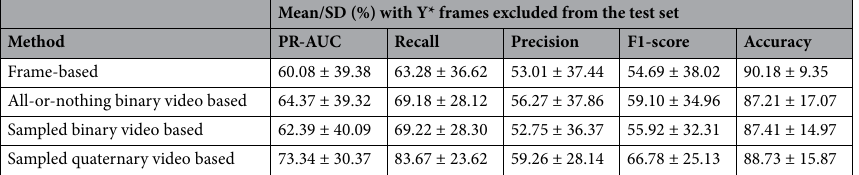
Table 5. The mean/std test-set metrics for the 10-fold cross validation, for which videos labelled N (Section II. A2) were excluded. One of the 10 folds, which contained only healthy frames, was excluded from the results. Here Y* frames are frames Y* videos (Section